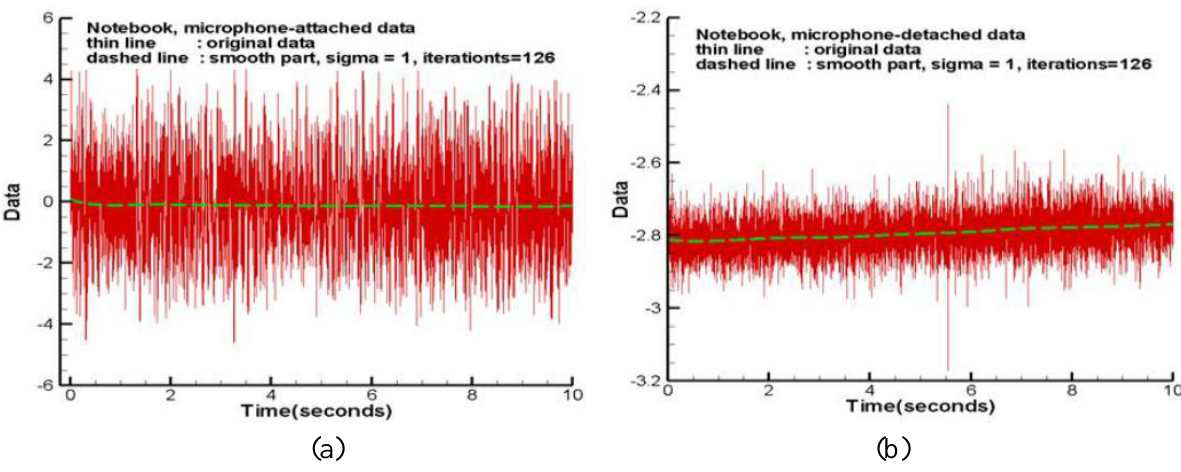
Figure 7. Raw data of a notebook computer: (a) microphone attached to the right board of touchpad. (b) microphone at 2 cm above the touchpad.